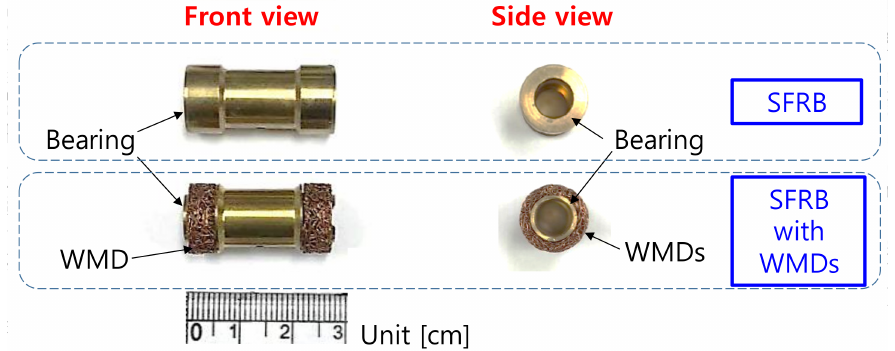
Figure 2. Photograph of commercial SFRB ( top figures) and wire mesh damper (WMD) integrated SFRB ( bottom figures) for the present study. Left and right figures show front and side views,